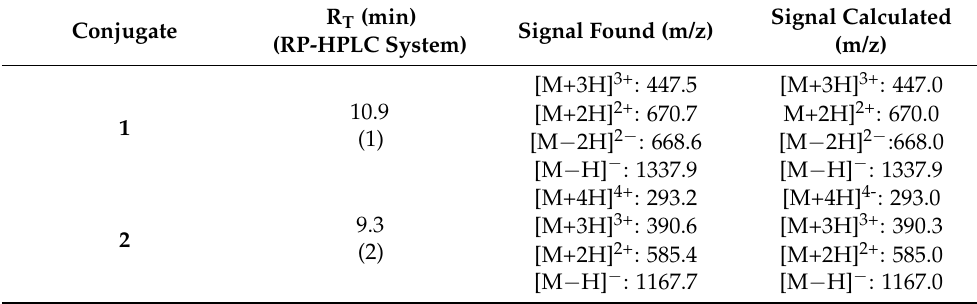
Table 1. Results of the ESI-MS analyses of synthesized conjugates 1 and 2 . R T (min) Signal Found (m/z) Signal Calculated (m/z) Conjugate (RP-HPLC System)